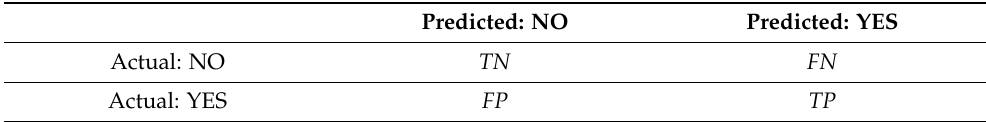
Table 3. Patient information providing experimental